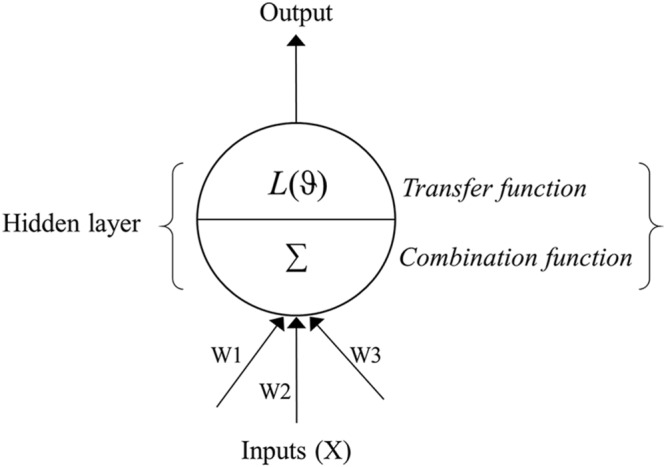
Schematic flow of an artificial neural network (ANN) depicting the input, hidden and output layers. The input layer contains predictors (Xi), while the output layer contains the response variable. The hidden layer is composed of the combination (Σ) and transfer (L) functions and summarizes predictor variables and associated weights (W), applies the transfer function, and sends the result to the output layer. The weights (W1, W2, W3…etc.) link input and hidden layer of the neural network.